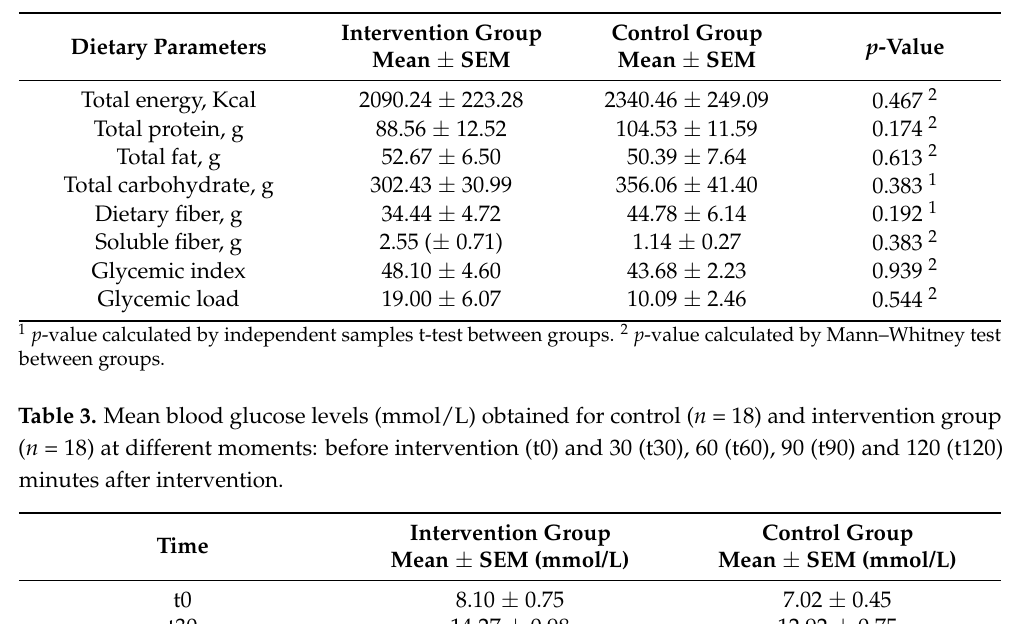
Table 2. Mean ( ± SEM) values of the dietary parameters on the day before the intervention for intervention ( n = 18) and control ( n = 18) group.